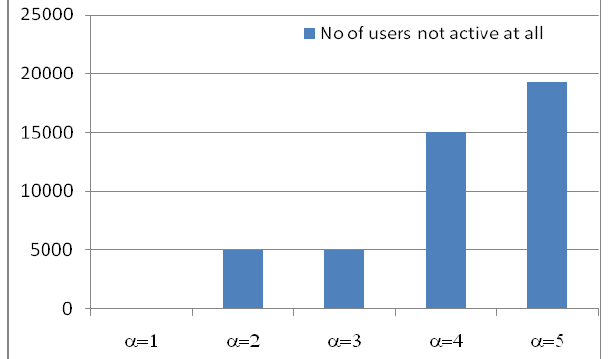
Figure 6 Number of users who are not active at all in relation to α value